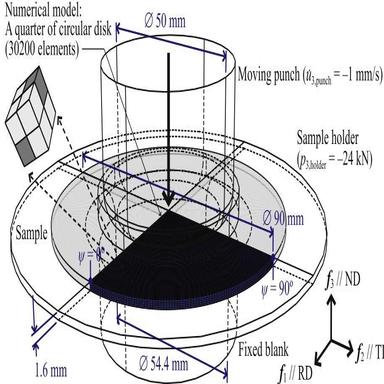
Setup of the deep drawing simulations. RD: Rolling Direction, ND: Normal Direction, TD: Transverse Direction. Figure adopted from with permission from IOP Publishing.